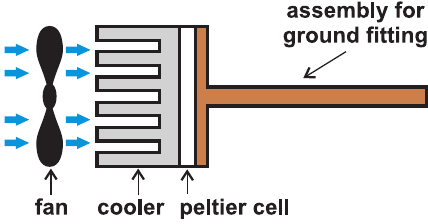
Figure 13. Assembly for ground